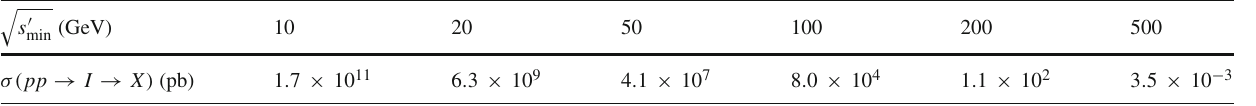
Table 1 Overview of expected cross sections of Instanton processes with different values of